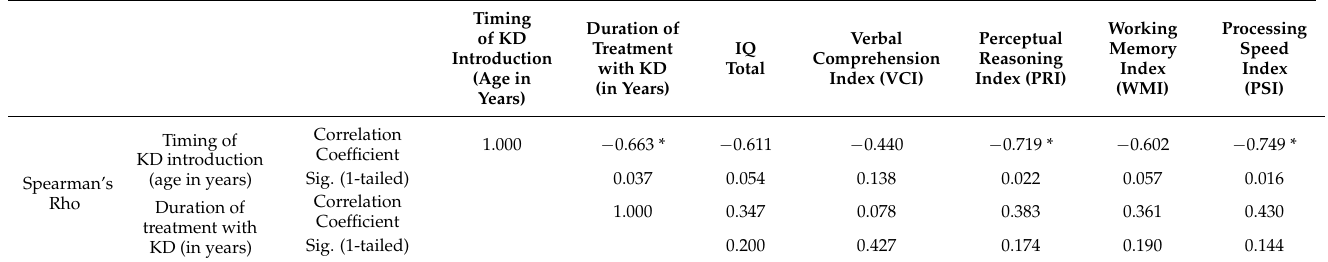
Table 3. Correlation between cognition (IQ total/indices) and timing of KDT introduction/duration of treatment with KDT.